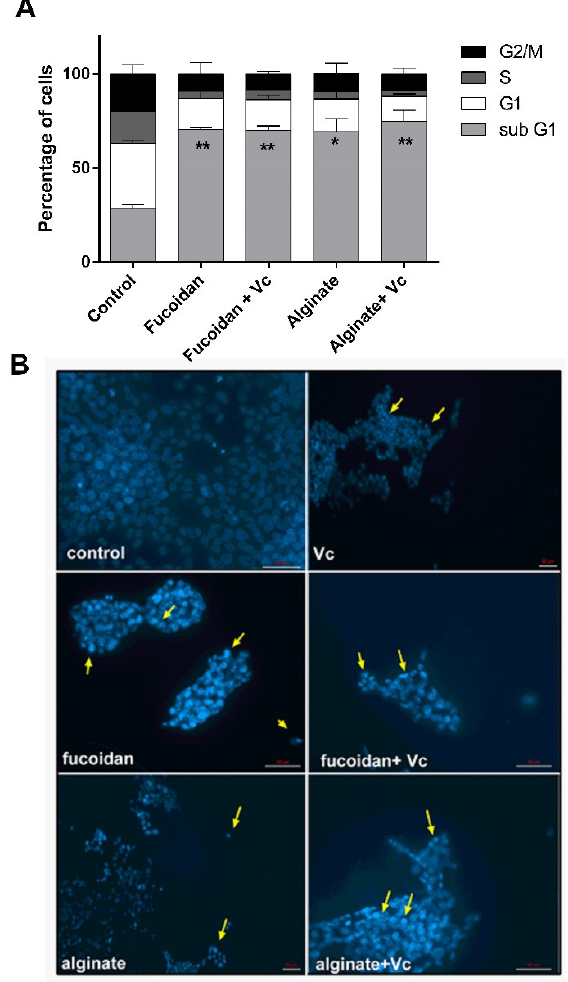
Figure 9. Cell cycle and morphological analysis of HCT-116 colorectal cancer cells treated with fucoidan, alginate, and their combination with vitamin C ( A ) Flow cytometry analysis shows the effects of fucoidan, alginate, and their combination on the cell cycle progression at 24 h; ( B ) DAPI micrographs of HCT-116 cells indicated that nuclear fragmentation and chromatin condensation occurred in vitamin C, fucoidan, and alginate-treated cells alone or with vitamin C combination. Nuclei were counterstained with DAPI (blue), scale bars = 50 µm. Significant differences vs. control cells, comparing cell cycle phases (SubG1, G0/G1, S, G2/M), are indicated as * p < 0.05 and ** p < 0.01 with respect to control.